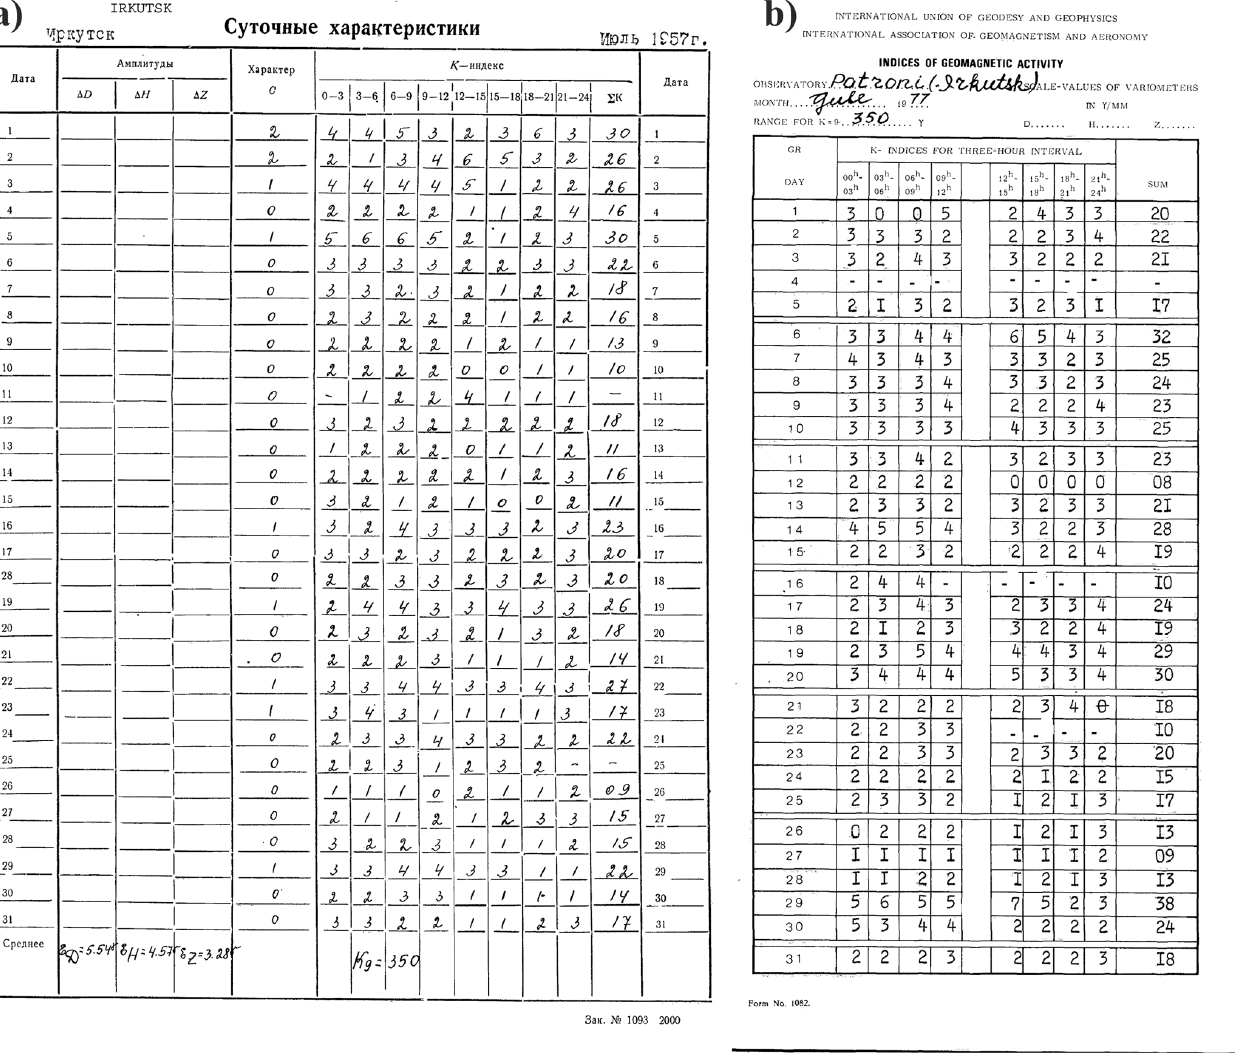
Figure 5. Paper data sheets for K index values for observatory Irkutsk (Patrony): (a) data sheet form adopted for the IGY (July 1957); (b) data sheet form adopted by IAGA in 1977 (July 1977) (http://www.wdcb.ru/stp/data/K_indices/IRT_Irkutsk/, last access: 1 September